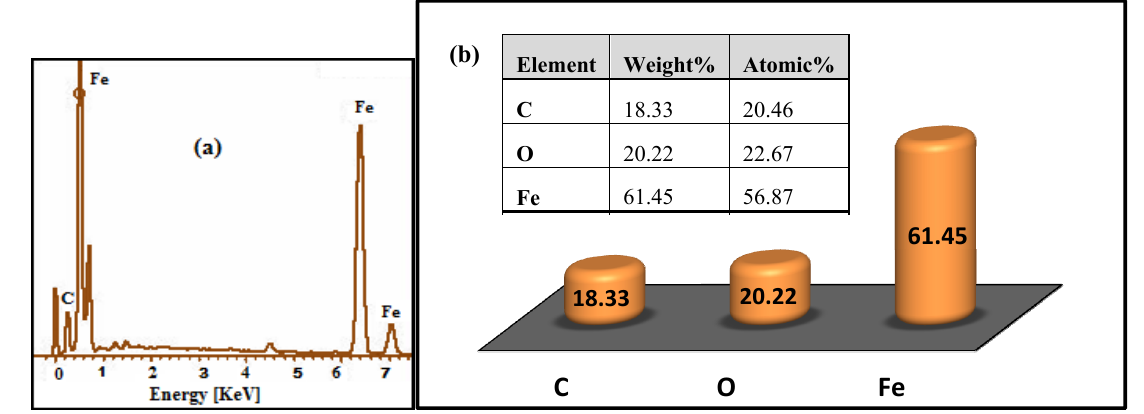
O MNPs, and ( b ) percentage of Fe, O, and 3 4